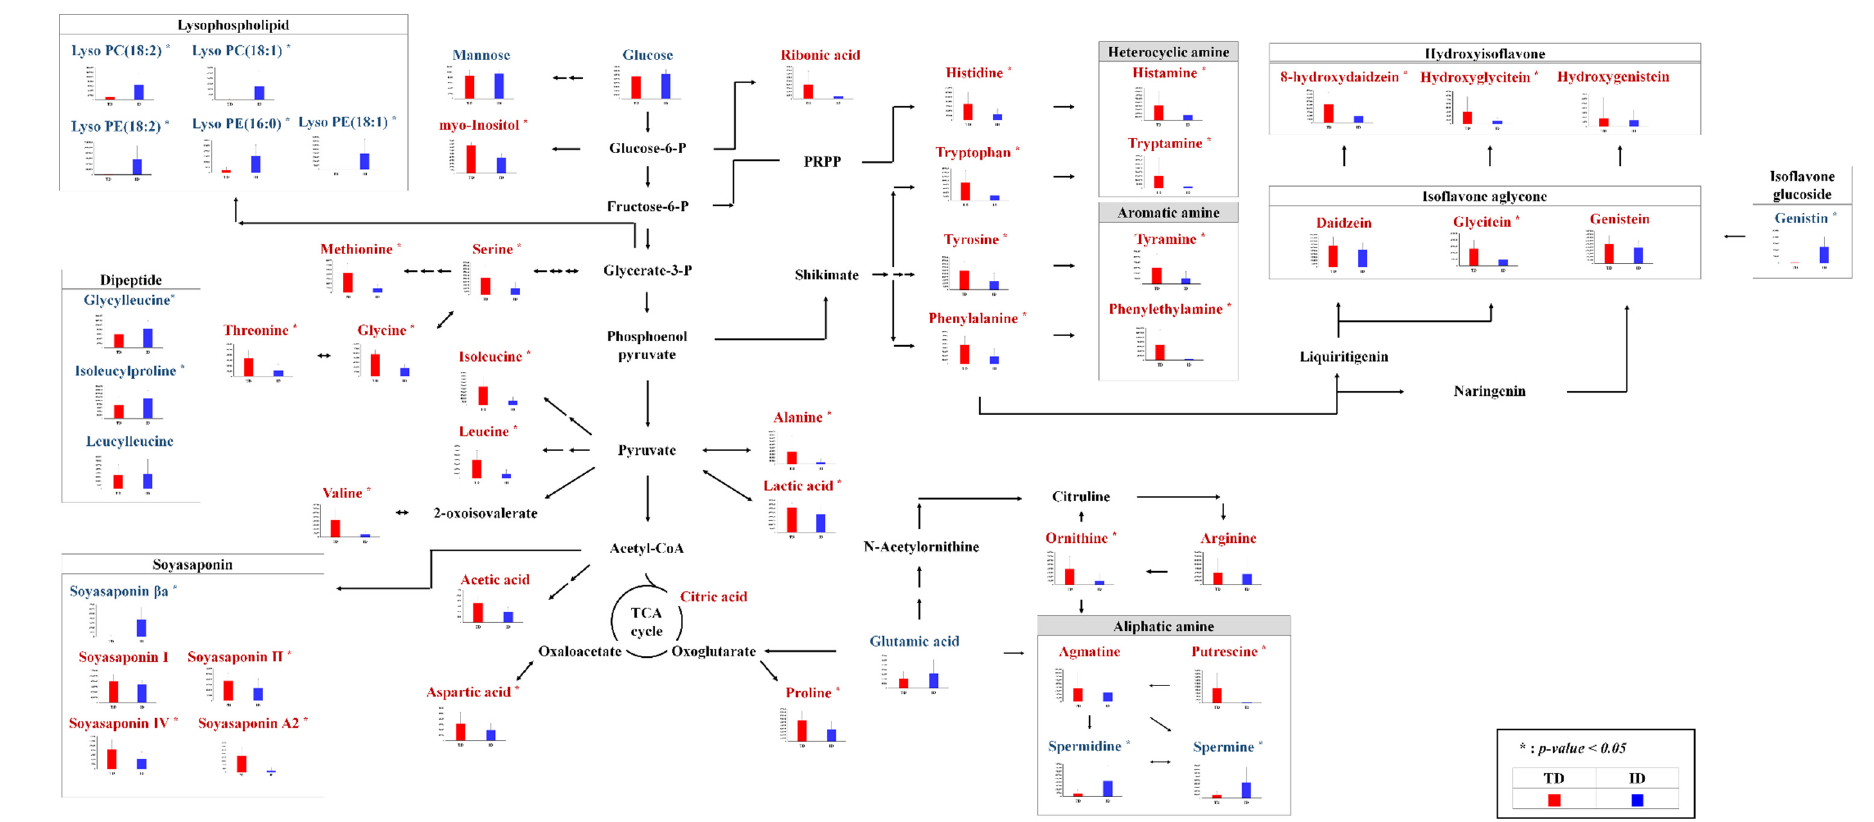
Figure 2. Scheme of the primary and secondary metabolic pathway and relative metabolite contents of traditional and industrial doenjang . The metabolic pathway was adopted from the KEGG database. The Y-axis of the graph represents peak areas of respective metabolites. Color of metabolite names represents comparatively abundant metabolites in traditional (red) and industrial (blue) doenjang.